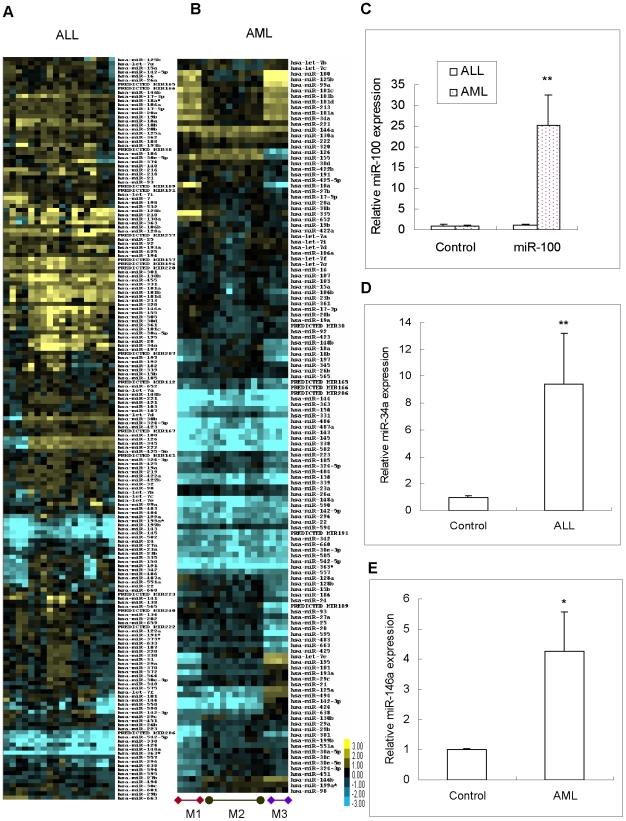
Cluster analysis in pediatric ALL and AML and miRNA expression in pediatric ALL and AML validated with qRT-PCR using the validation cohort.(A) The 182 top–ranked differentially expressed miRNAs in pediatric ALL; (B) The 131 top–ranked differentially expressed miRNAs in the French-American-British (FAB) classification of pediatric AML; (C) MiR-100 expression in pediatric ALL and AML validation cohort (p = 0.000); (D) MiR-34a was up-regulated in pediatric ALL validation cohort (p = 0.003); (E) MiR-146a was up-regulated in AML validation cohort (p = 0.046).